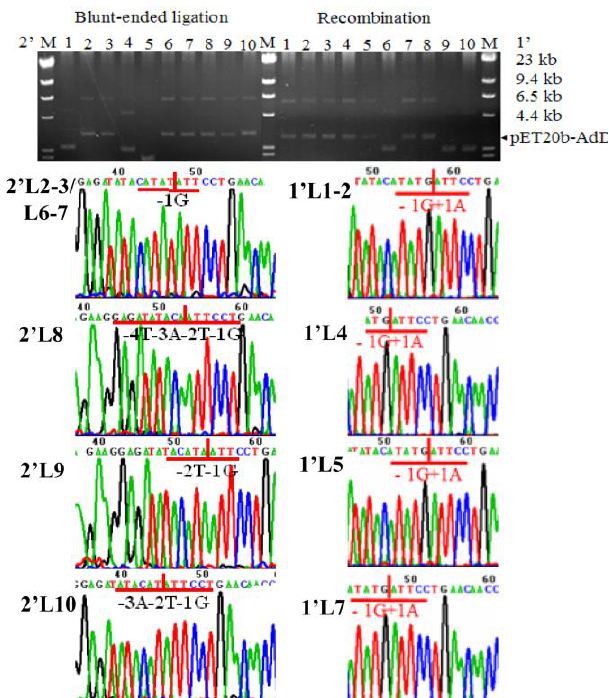
expected sizes were sequenced to check junctions scarless or not. Quantity of nicked plasmid DNAs were analyzed by Gel-Pro Analyzer 4.0.